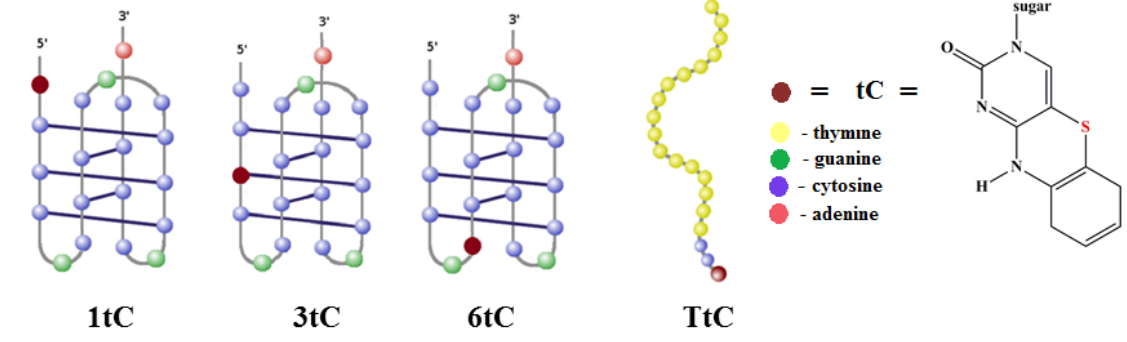
Figure 1. Structures of intramolecular i-motifs formed by 1tC, 3tC, and 6tC probes and single stranded structure of TtC probe. The positions of the fluorescent cytosine analogue are marked with brown circles, cytosine is depicted as blue circle, thymine—as yellow circle, guanine—as green circle and adenine—as red